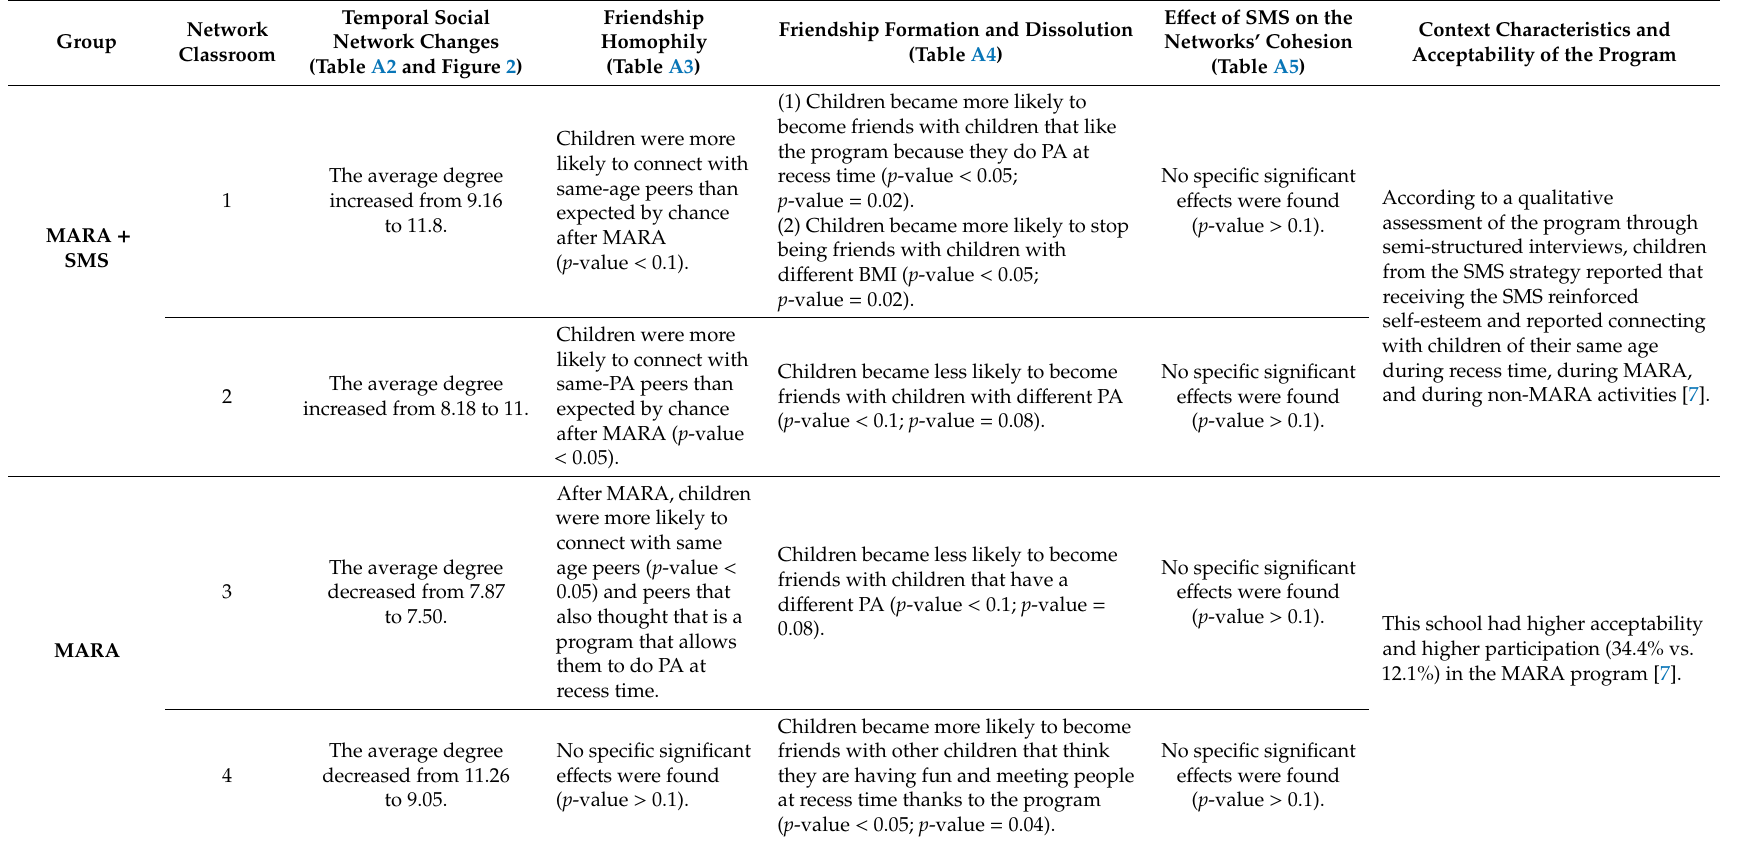
Table 3. Summary of the specific results for each friendship